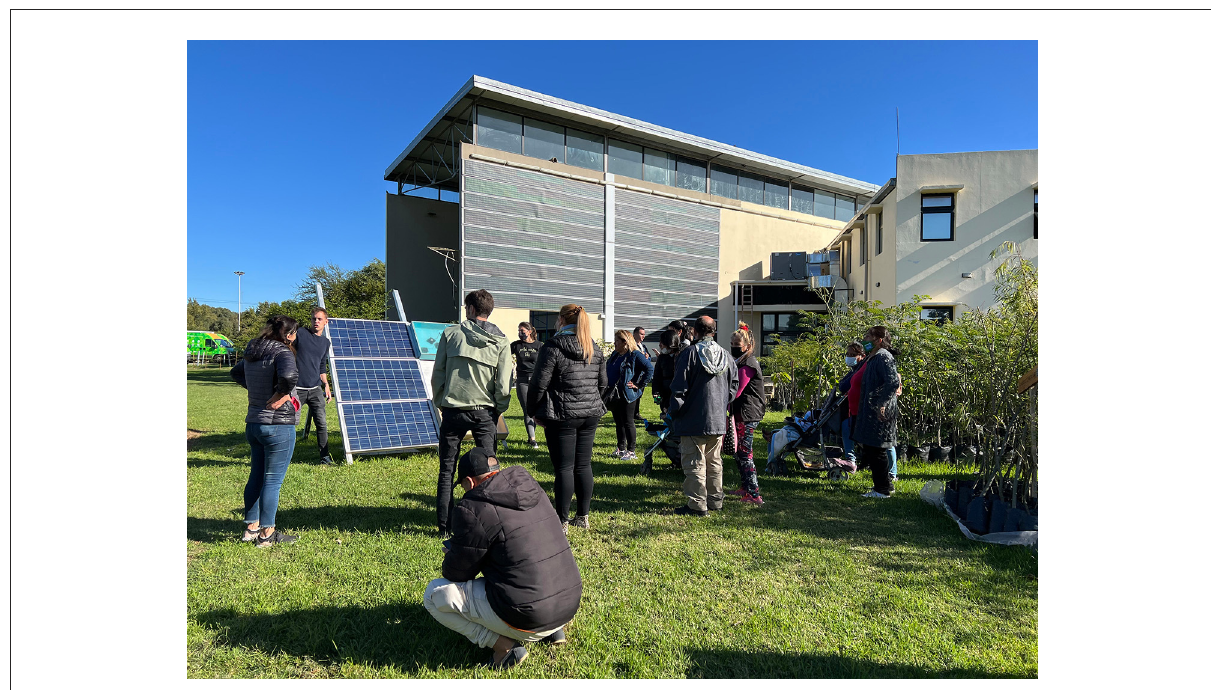
FIGURE5 Visit to Paseo Ambiental del Sur APRA, April 2022. Source TUC Program.